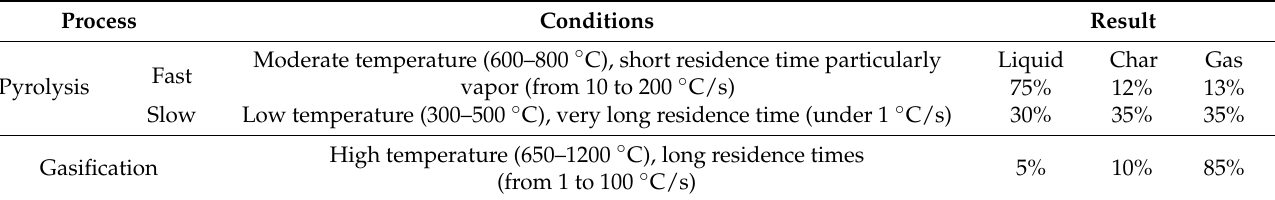
Table 2. Typical product yields obtained by biomass